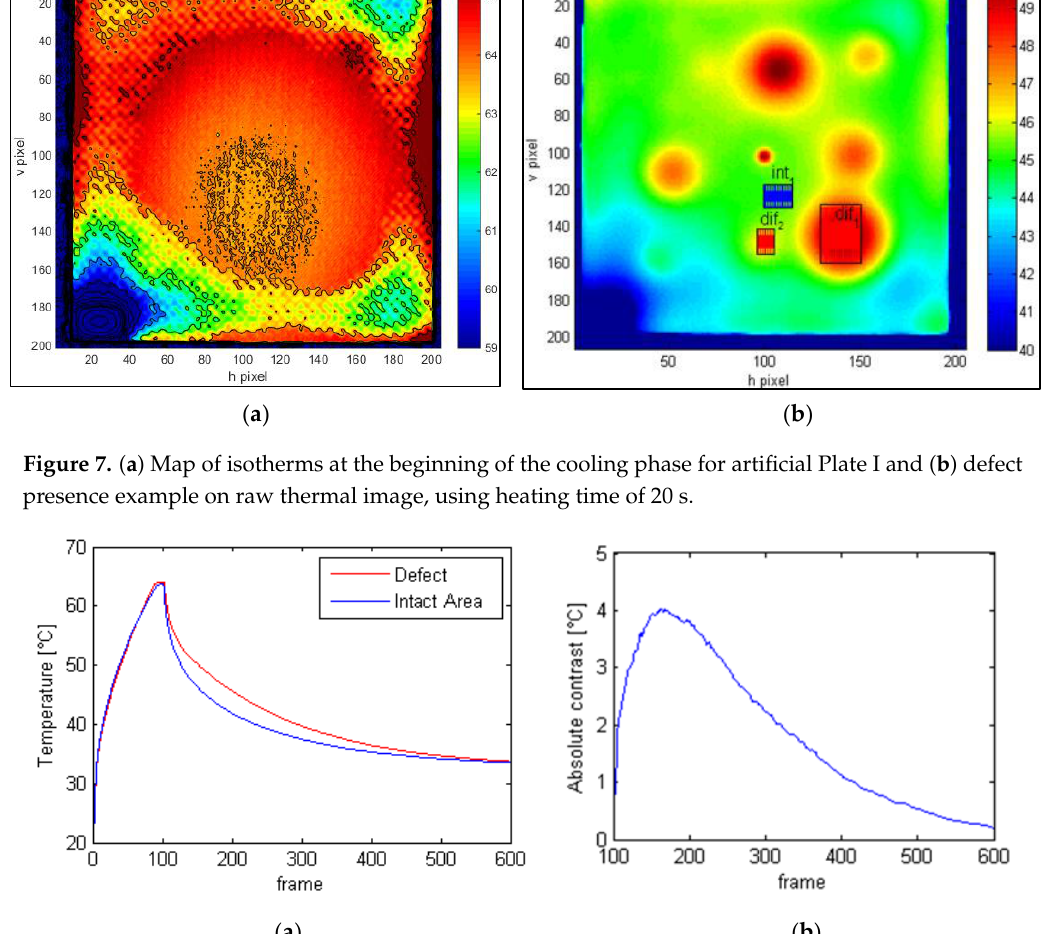
Figure 8. ( a ) Thermal profiles and ( b ) absolute contrast example for defect-1 (Ø 25 mm) and intact area in Plate I, using heating time of 20 s.